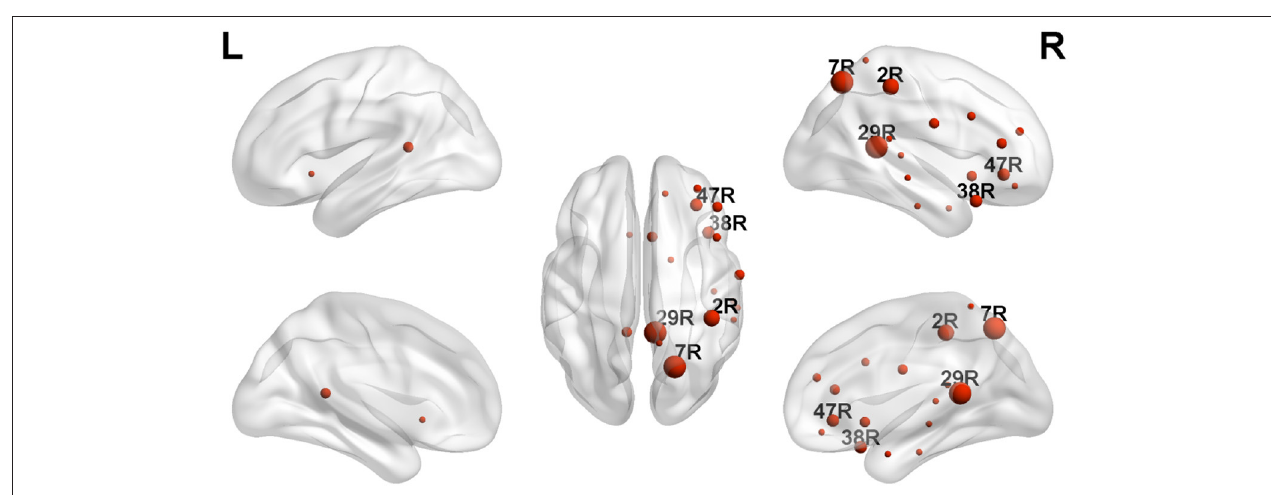
FIGURE 6 | The locations of ROIs with significant group effect (TD > ASD) revealed by NBS. The size of each ROI corresponds to its number of significantly altered TV-PS time series. Only the labels of crucial hubs were shown.